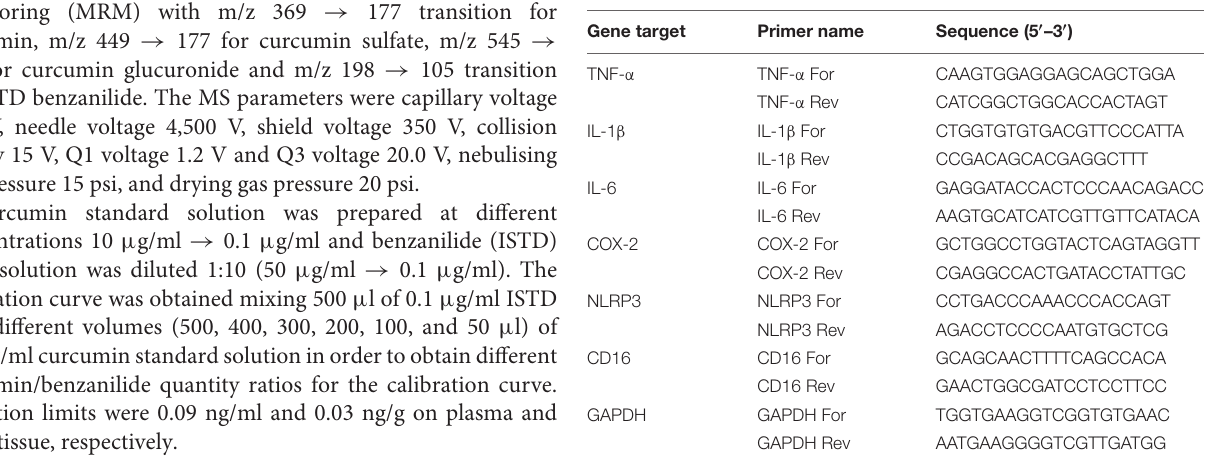
TABLE 1 | Primers for real-time PCR used in this